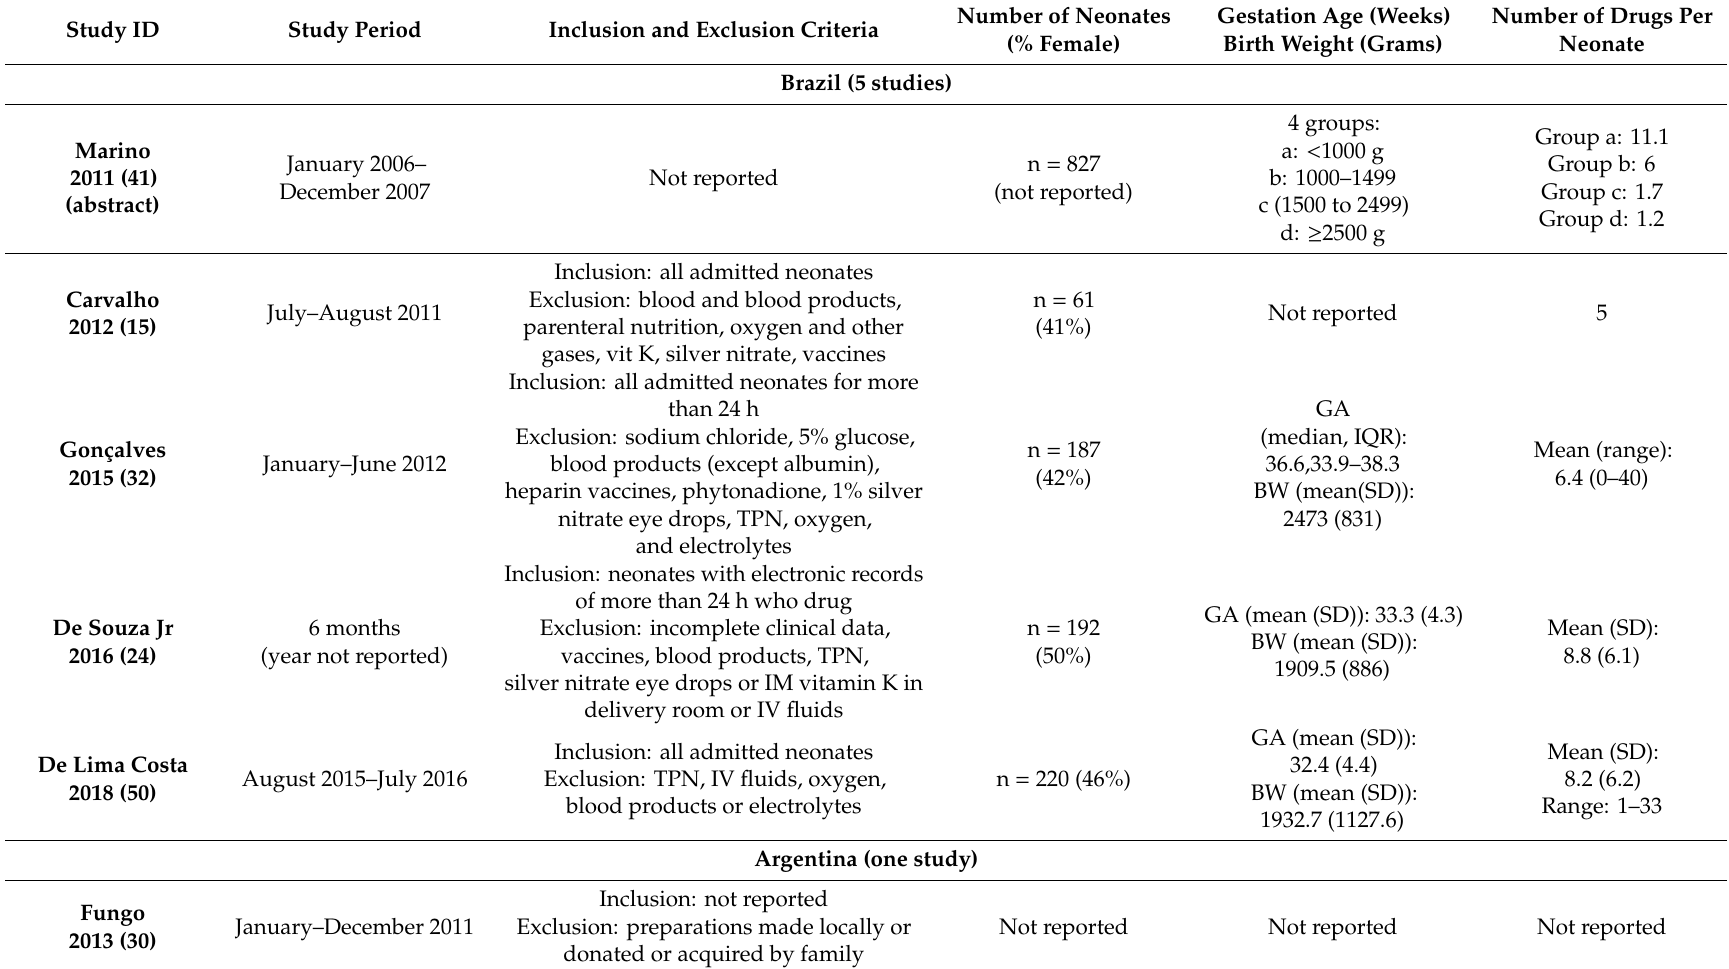
Table A6. Studies of drug utilization in Latin America and Caribbean (6